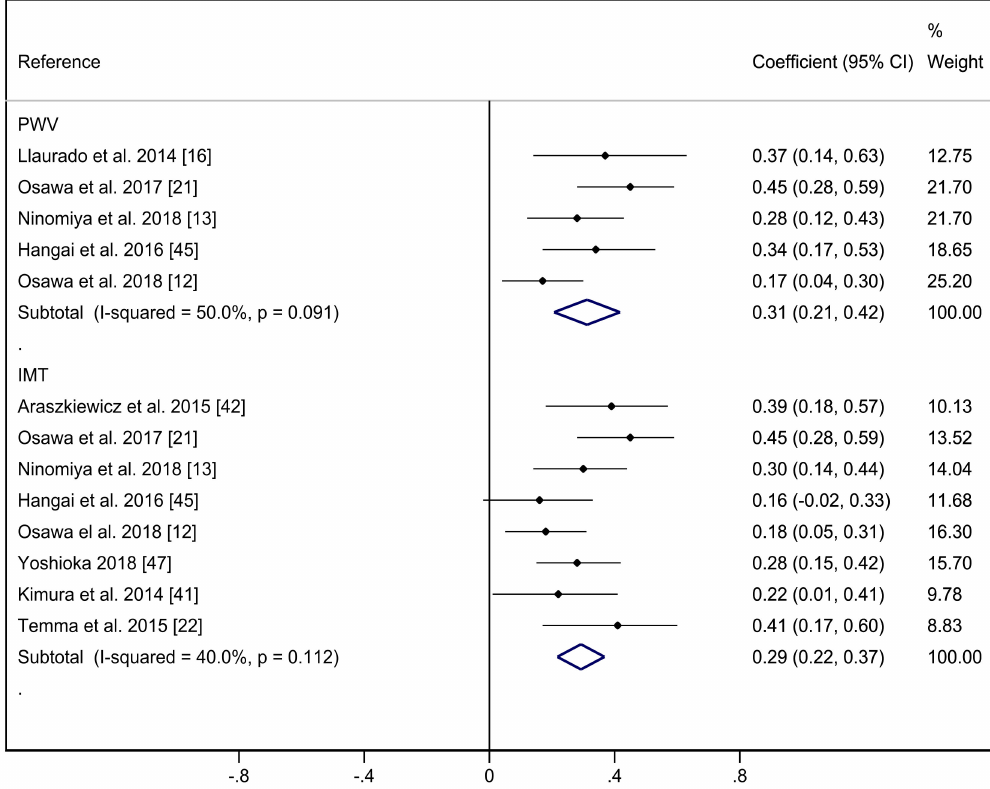
Figure 3. Forest plot including correlation between pulse wave velocity or carotid intima media thickness and skin autofluorescence in diabetic